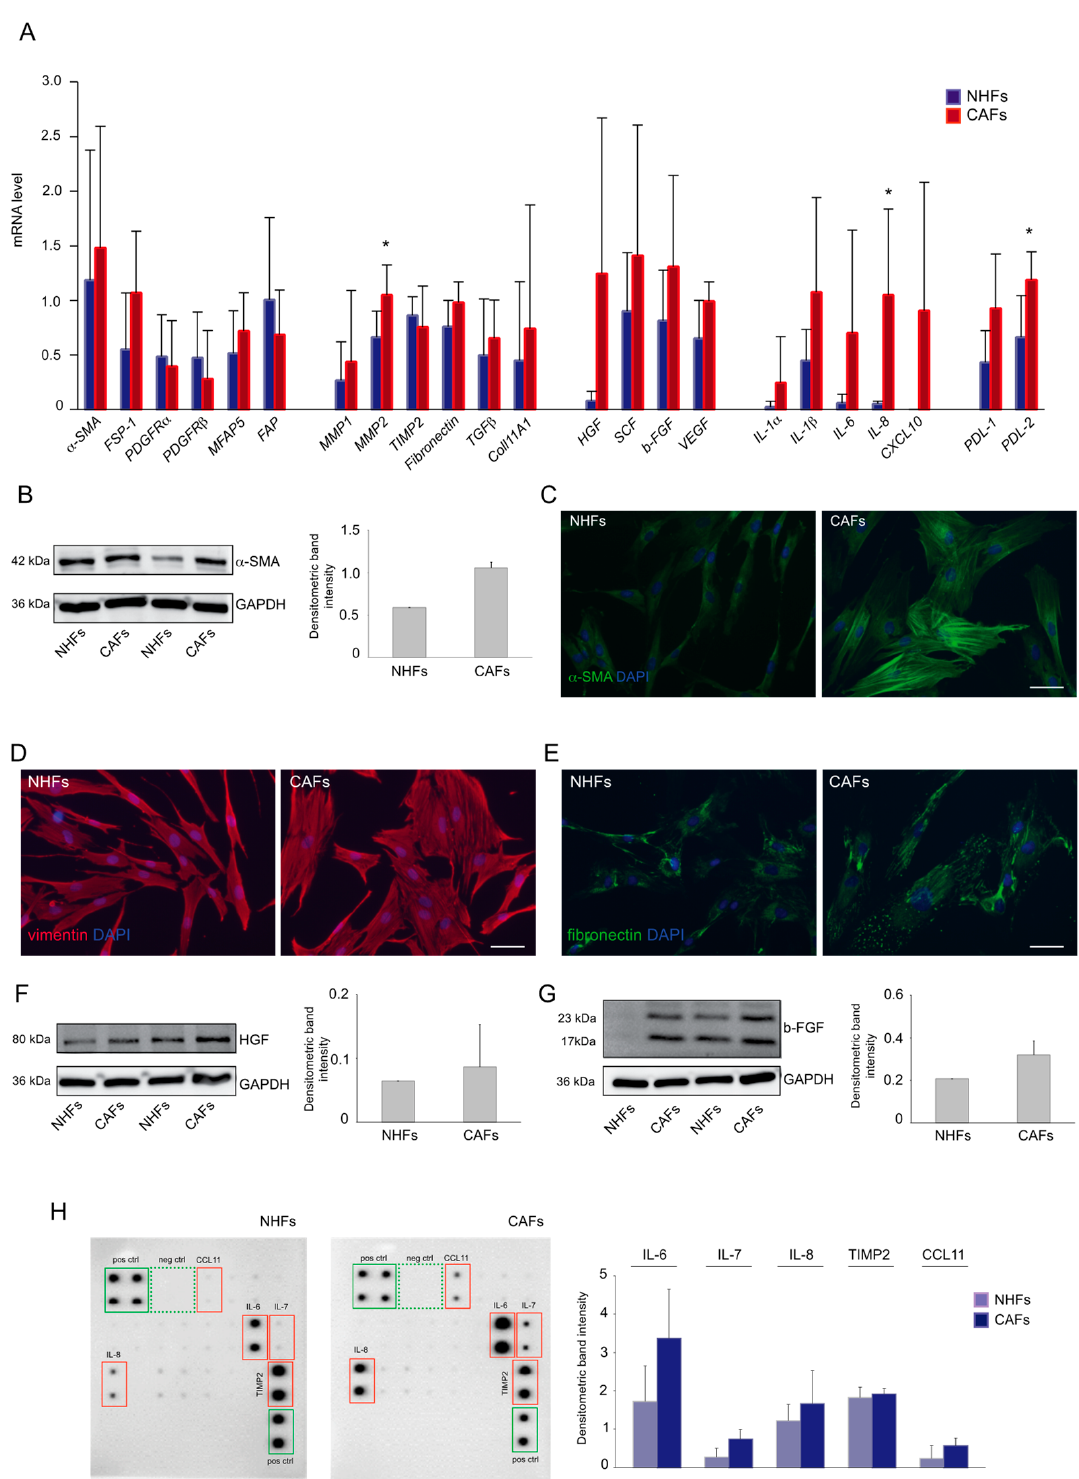
Figure 1. Characterization of melanoma CAF cultures. ( A ) mRNA levels of a panel of markers commonly used to identify cancer-associated fibroblasts. β -actin mRNA was used as reference. (NHFs n = 6, CAFs n = 7) * p < 0.05 vs. NHFs. ( B ) Western blot and densitometric analysis of α -SMA expression in NHFs ( n = 6) and CAFs ( n = 7). ( C ) Immunofluorescence analysis of α -SMA (green) expression detected in control ( n = 6) and cancer-associated fibroblasts ( n = 7). Nuclei are counterstained in DAPI. Scale bar: 50 µ m. Immunofluorescence staining for vimentin (red) ( D ) (NHFs = 6; CAFs = 7) and fibronectin (green) ( E ) (NHFs = 5; CAFs = 5). Nuclei are counterstained in DAPI. Scale bar: 50 µ m. Western blot and densitometric analyses of HGF ( F ) and b-FGF ( G ) in control ( n = 6) and cancer-associated fibroblasts ( n = 7). Protein array and densitometric analysis ( H ) showing the expression of inflammatory-related markers in NHFs ( n = 6) and CAFs ( n = 7).